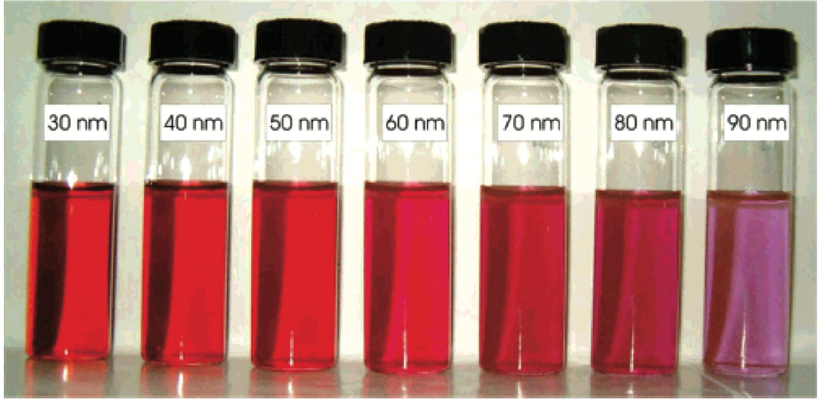
Figure 3. Different sizes of spherical AuNPs correspond to different color solutions. Reprinted (adapted) with permission from [24]. Copyright 2007, American Chemical Society.